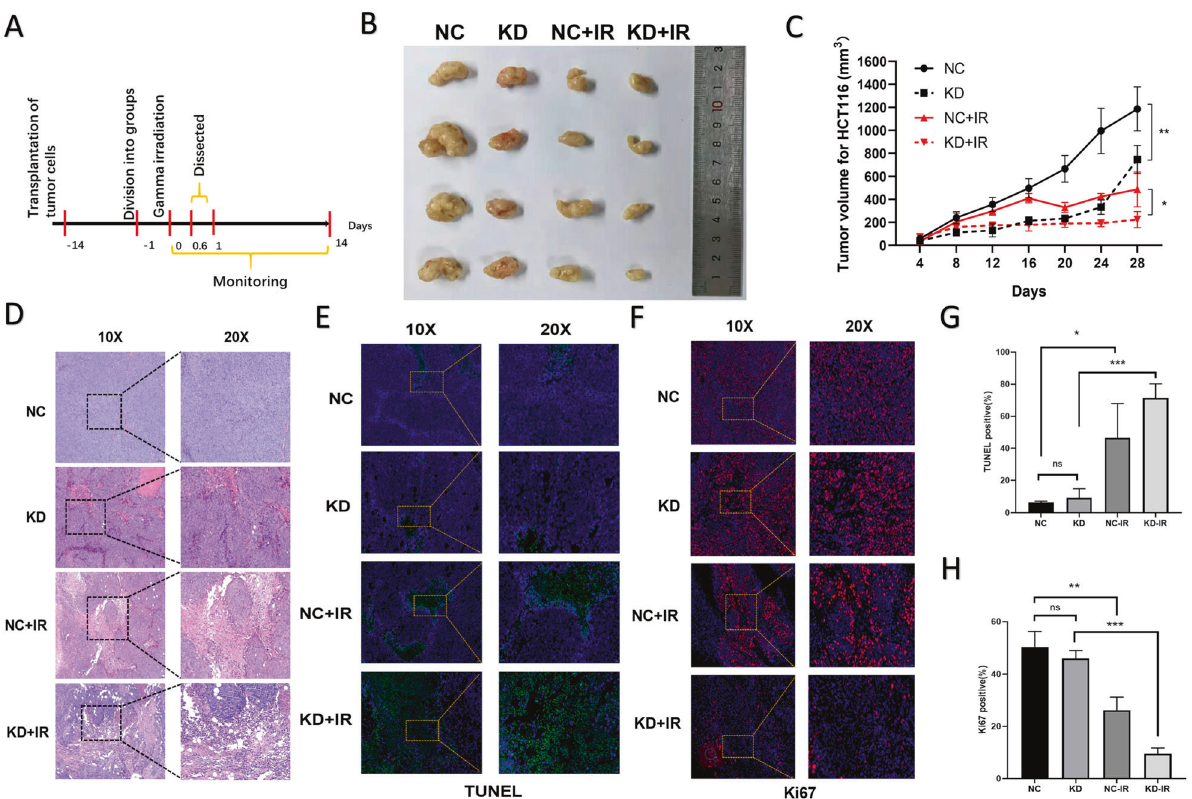
Fig. 6 PRDM15 promotes the radioresistance of CRC in CDX models. A The overall design of the animal experiments. B Representative images of xenograft tumors in different groups at 28 days after 15 Gy local radiotherapy in pelvic cavity. C Tumor volume growth from the PRDM15-NC and PRDM5-KD groups with/without IR. Error bars represent the SD of the mean of four independent animals. two tailed Student ’ s t test was applied in NC and KD groups with the same intervention. * P < 0.05, ** P < 0.01, *** P < 0.001 and **** P < 0.0001 versus untreated control. D Representative 10× and 20× images of H&E immunohistochemical staining of tumor tissue sections in different groups at 12 h after 15 Gy local radiotherapy in pelvic cavity. E , F Representative 20× and 40× images of TUNEL and Ki67 immuno fl uorescence staining of tumor tissue sections in different groups at 12 h after 15 Gy local radiotherapy in pelvic cavity. G , H Respective percentage of TUNEL ( + ) and Ki67 ( + ) cells in tumor by quantitative analysis. Data are shown as the mean ± SD, one-way ANOVA, * P < 0.05, ** P < 0.01 and *** P <